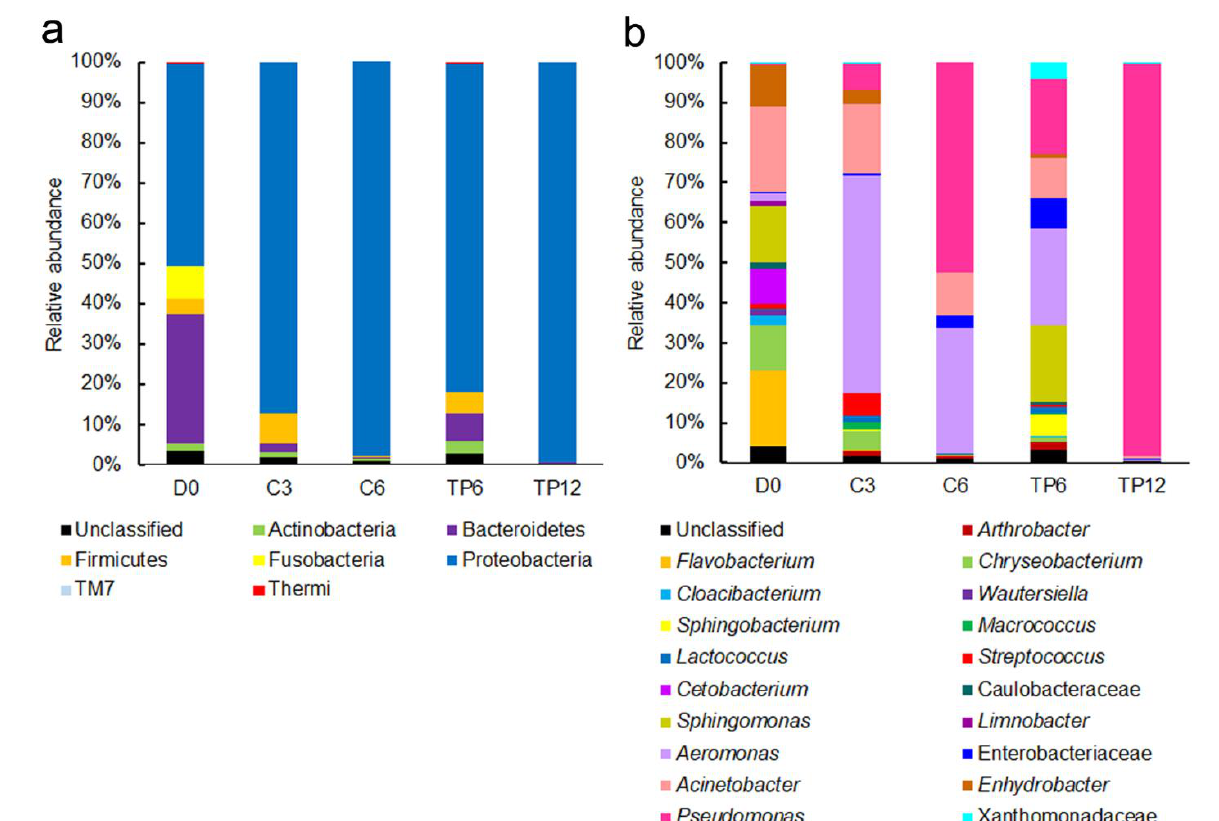
Figure 4. Relative abundance of the bacterial phyla ( a ) and genera ( b ) in crisp grass carp fillets during chilled storage at 4 °C. Only genera ≥ 1% of the total relative abundance of the samples are shown.